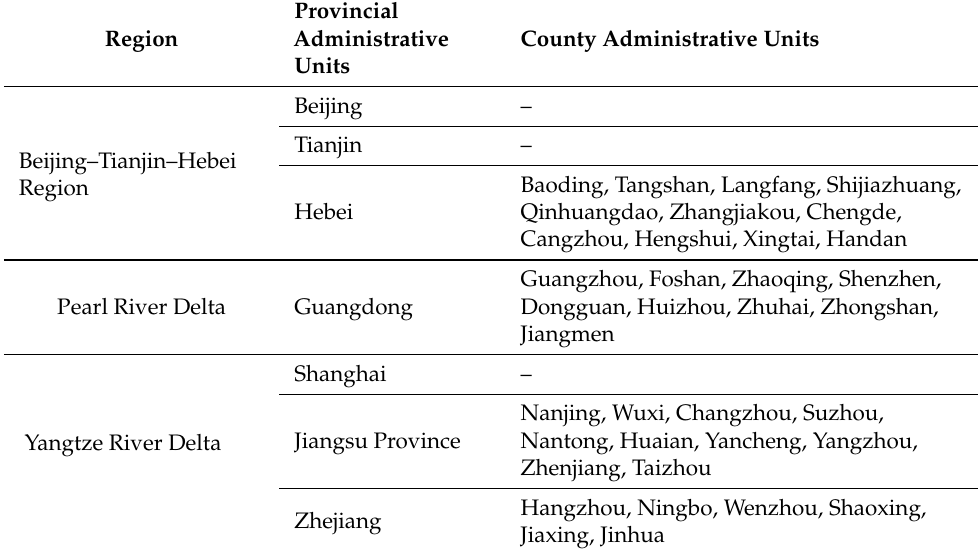
Table 6. Three regions used to construct the